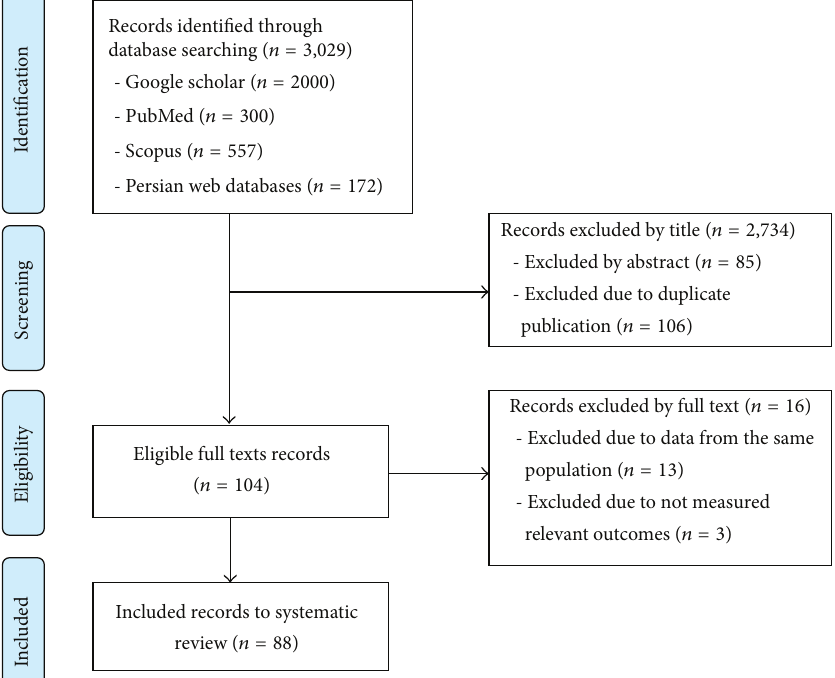
Figure 1: Flow diagram of study selection